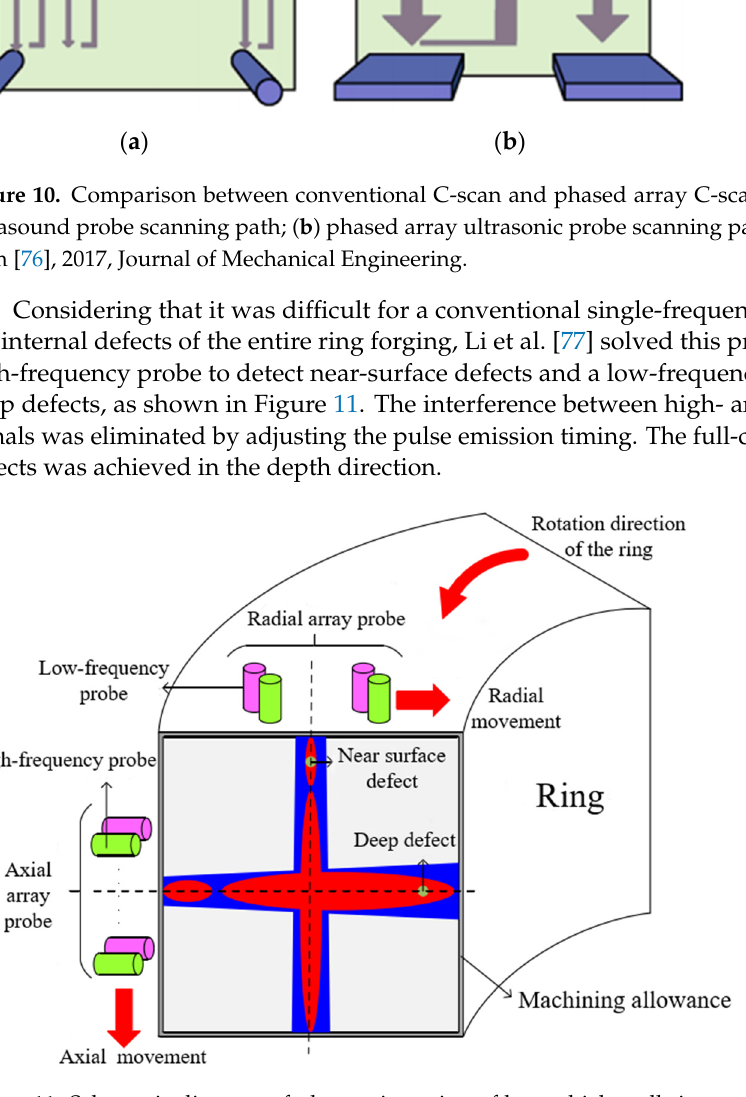
Figure 11. Schematic diagram of ultrasonic testing of large thick-wall ring array with permission from [77], 2019, Wuhan Univ. Technol.